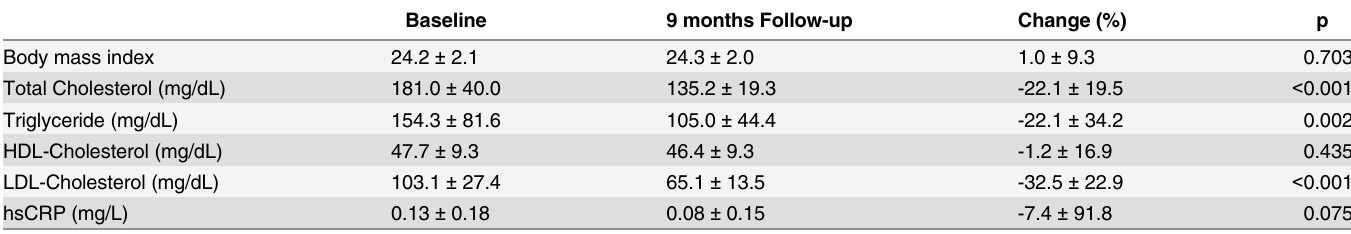
Table 2. Laboratory results.